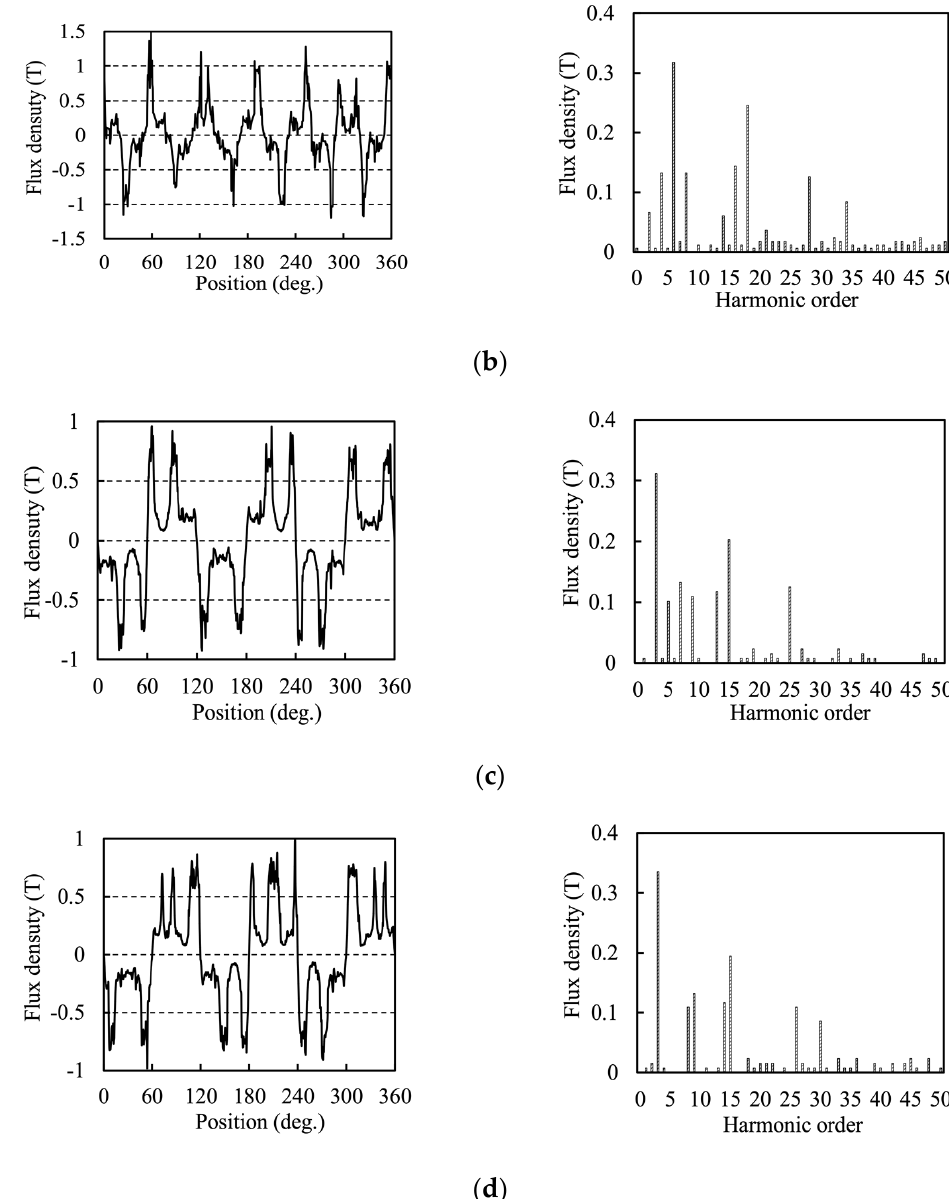
Figure 4. Open-circuit air-gap flux density and harmonic distribution of the four candidates. ( a ) 12/10 U-core; ( b ) 12/11 U-core; ( c ) 6/10 E-core; ( d ) 6/11 E-core.